Question: Condense the content of this figure into a single sentence.
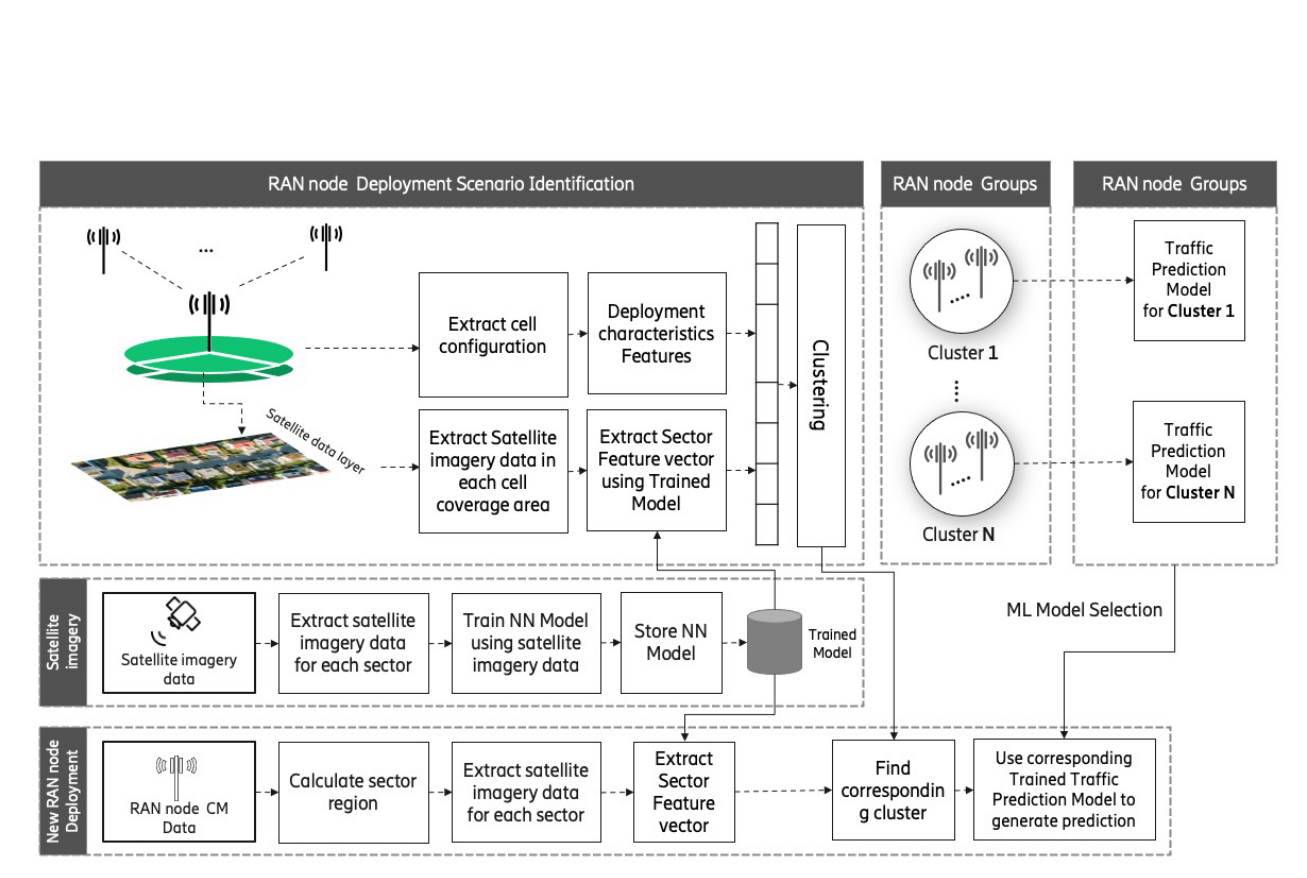
Answer: Workflow of the geospatial data-enhanced forecasting methodology. The process begins with the identification of RAN node deployment scenarios, followed by the extraction of cell configuration and satellite imagery data. This data is then utilized to train a neural network model, which informs the clustering of RAN nodes based on deployment characteristics. Each cluster is then associated with a tailored traffic prediction model, allowing for efficient and targeted traffic forecasting across the network.